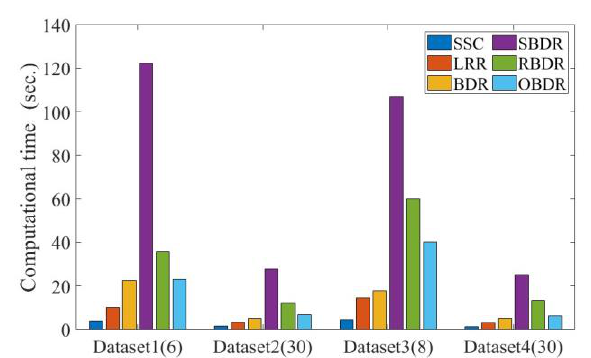
Figure 5. The computational time of algorithms on Dataset1~Dataset4.